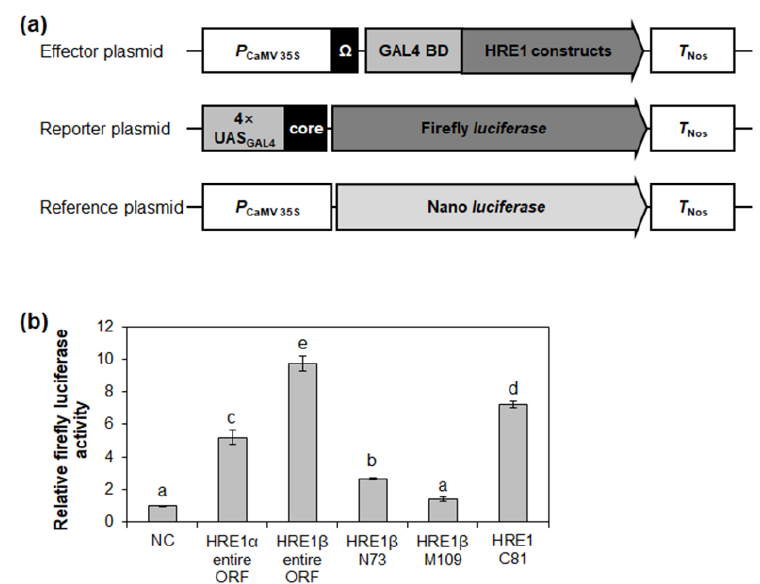
Figure 7. Analysis of transactivation activities of HRE1 α and HRE1 β . ( a ) The schematic maps of the e ff ector plasmid, reporter plasmid, and reference plasmid for the analysis of transactivation activities of full-length ORFs of HRE1 α and HRE1 β , and truncated fragments of HRE1 β . ( b ) The relative firefly luciferase activity in Arabidopsis protoplasts. The transformation e ffi ciency was normalized with Nano luciferase activity of the reference plasmid. The normalized firefly luciferase activity of negative control was set as 1. The empty e ff ector plasmid was used as a negative control. The data shown are the means ± S.D. ( n = 3). The data were analyzed with one-way ANOVA using Tukey’s multiple comparison test. Di ff erent letters indicate significant di ff erences ( p < 0.05).